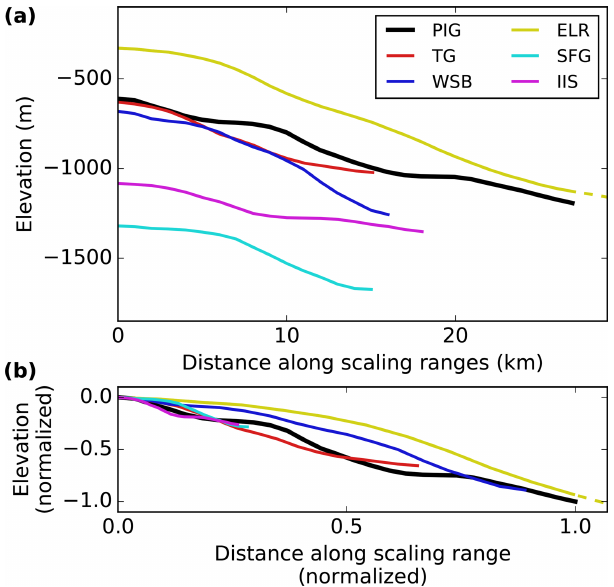
Figure 3. (a) Unscaled bed topography of retrograde slope sections of the six examined Antarctic outlets that fulfill the time-scaling cri- teria. (b) Bed topography from panel (a) scaled according to simili- tude theory using the horizontal and vertical length–scale ratios ob- tained from observations (see Table 1) and normalized to the di- mensions of the PIG slope (that has the same aspect ratio in both panels). For better visibility the x and y axis are cut (see Fig. S4 for full extent of the ELR bed